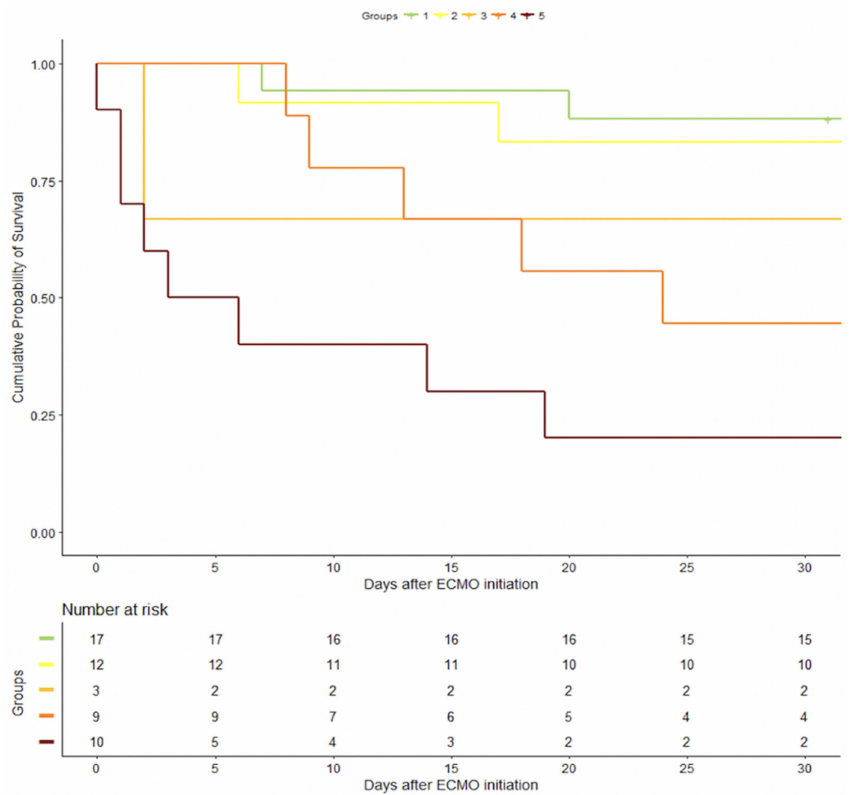
Figure 1. Kaplan–Meier curves estimating the 30-day survival of patients implanted with a VA- veno-arterial extracorporeal membrane oxygenation (ECMO) for STEMI-related refractory cardio- genic